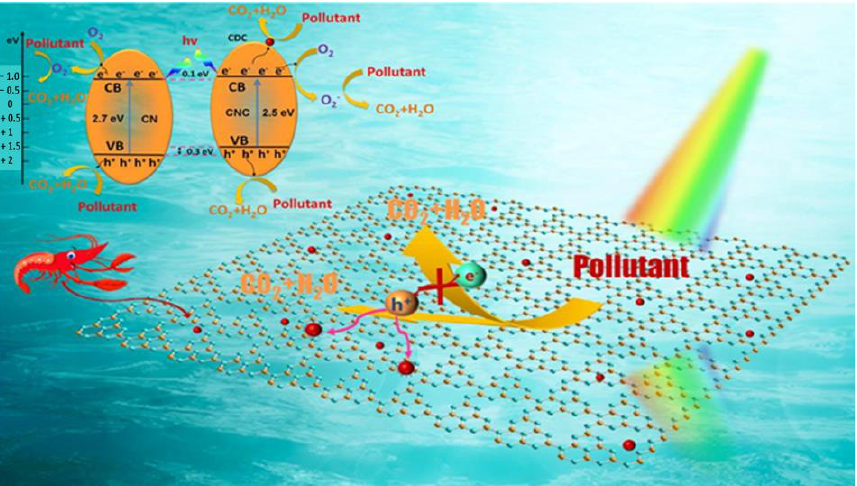
Figure 19. A facile strategy to minimize the recombination of photon-generated carrier while simulta- neously increasing the surface area by in situ constructing chitin-derived carbon/g-C 3 N 4 metal-free heterojunction. Adapted with permission from ref. [114].